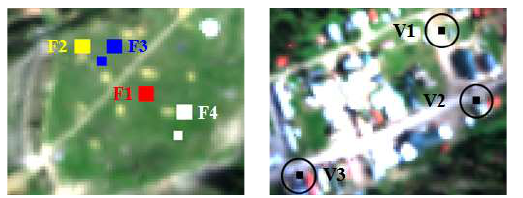
Figure 1. The HyMap dataset color image of Cook City, Montana, USA.